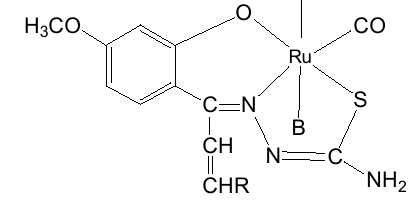
Figure 4. Proposed structure of the new ruthenium(II) chalcone thiosemicarbazone complexes (E = P or As; B = PPh